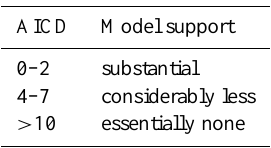
Table 2. AICD and their interpretation in respect to the achieved strength of model